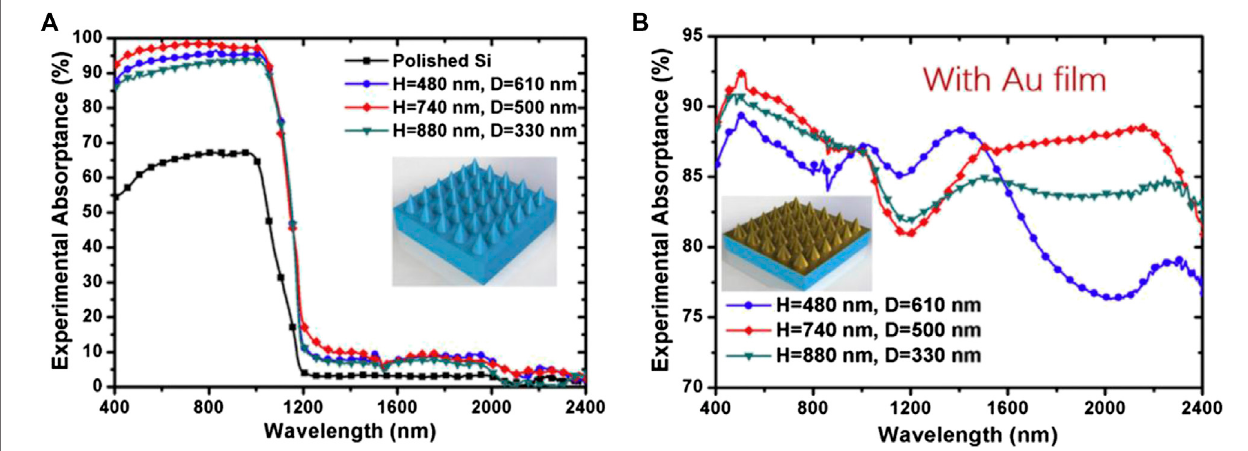
FIGURE6| Theabsorption ef fi ciencyofnanoconearrays withorwithoutAulayer.HandDistheheightanddiameterofthenanocone. Source :Reproduced from Ref. 29.